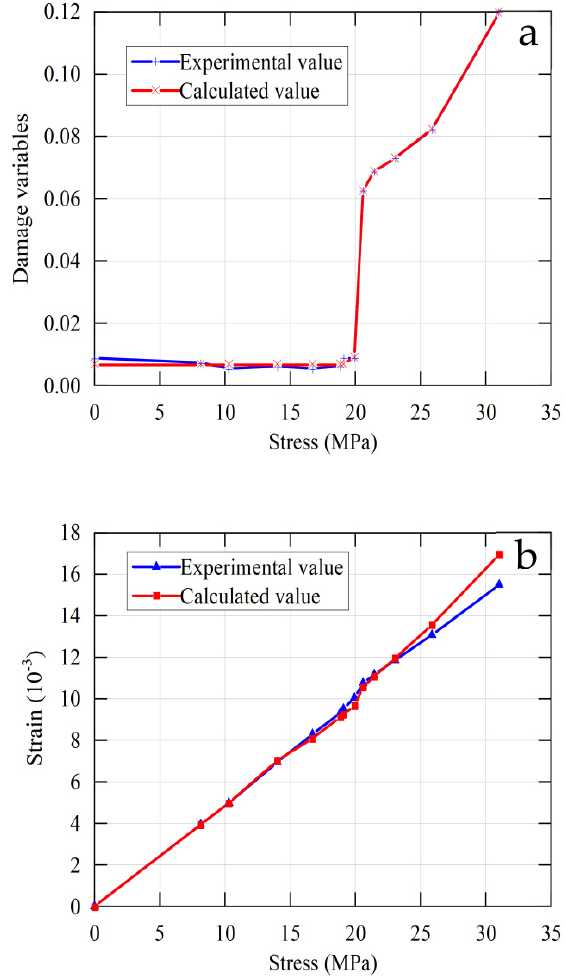
Figure 12. Comparison of experimental values and formula-calculation results: ( a ) comparison chart of calculated and experimental values of damage variables; ( b ) comparison chart of calculated-strain value and experimental value.